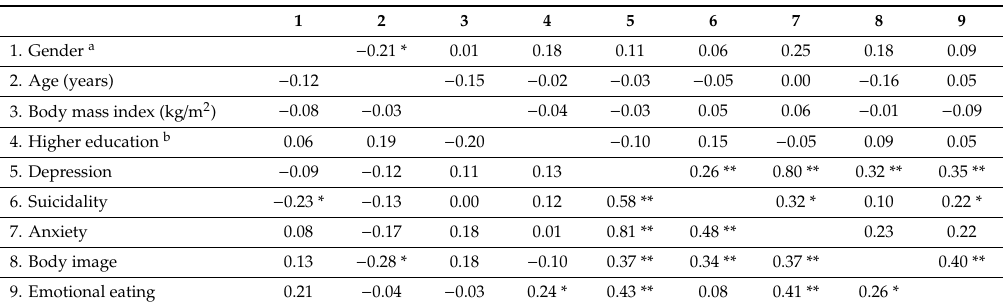
Table 2. Pearson correlation coe ffi cients between the study variables for both samples. Correlations above the diagonal correspond to the Israeli sample ( N = 114), while correlations below the diagonal correspond to the US sample ( N =